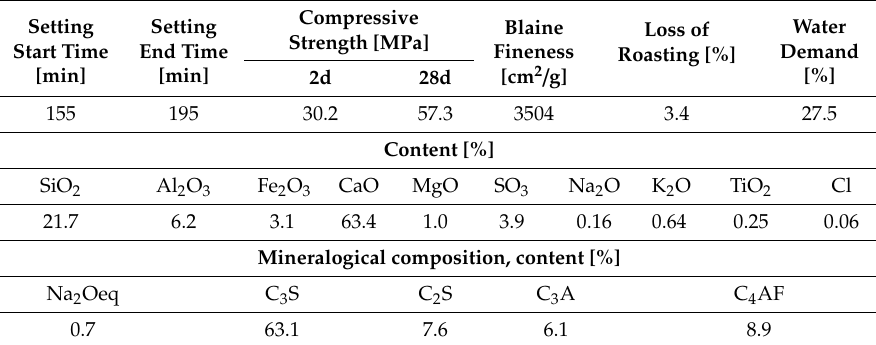
Table 1. Chemical composition and physical properties of cement CEM I 42,5R [15].